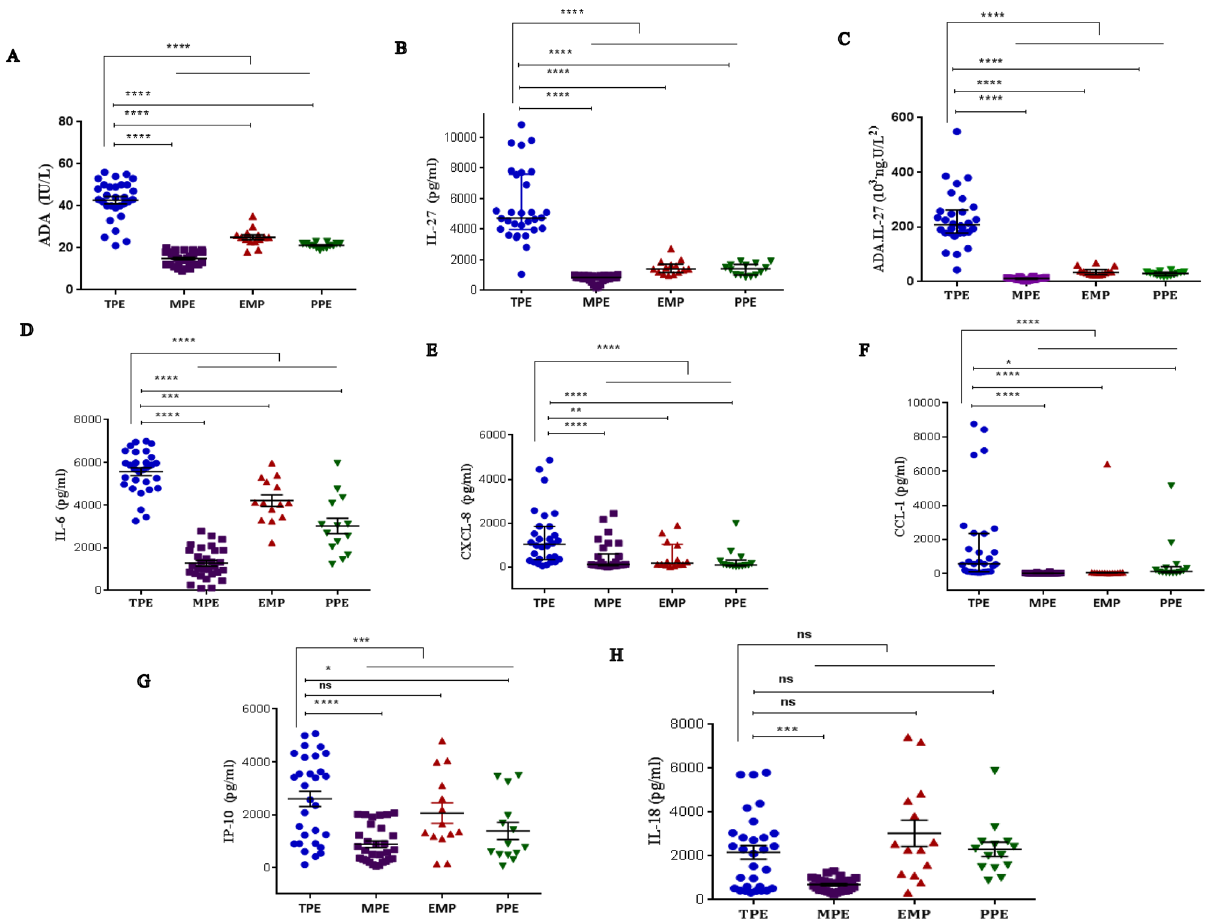
Figure 2. ( A ) ADA pleural fluid concentrations in TPE (n = 30) and in 3 etiologies of pleural effusions: malignant (n = 30), empyema (n = 14) and parapneumonic (n = 14) pleural effusions. In each data bar, Horizontal bars indicate mean and the bottom and top of the bar represent the standard error of the mean (SEM). ( B ) IL-27 pleural fluid concentrations in tuberculous pleural effusion (n = 30) and in 3 etiologies of pleural effusions: malignant (n = 30), empyema (n = 14) and parapneumonic (n = 14) pleural effusions. ( C ) ADA.IL-27 pleural fluid concentrations in tuberculous pleural effusion (n = 30) and in 3 etiologies of pleural effusions: malignant (n = 30), empyema (n = 14) and parapneumonic (n = 14) pleural effusions. ( D ) IL-6 pleural fluid concentrations in TPE (n = 30) and in 3 etiologies of pleural effusions: malignant, empyema and parapneumonic pleural effusions. ( E ) CXCL8 pleural fluid concentrations in TPE (n = 30) and in 3 etiologies of pleural effusions: malignant (n = 30), empyema (n = 14) and parapneumonic (n = 14) pleural effusions. ( F ) CCL1 pleural fluid concentrations in TPE (n = 30) and in 3 etiologies of pleural effusions: malignant (n = 30), empyema (n = 14) and parapneumonic (n = 14) pleural effusions. ( G ) IP-10 pleural fluid concentrations in TPE (n = 30) and in 3 etiologies of pleural effusions: malignant (n = 30), empyema (n = 14) and parapneumonic (n = 14) pleural effusions. ( H ) IL-18 pleural fluid concentrations in TPE (n = 30) and in 3 etiologies of pleural effusions: malignant (n = 30), empyema (n = 14) and parapneumonic (n = 14) pleural